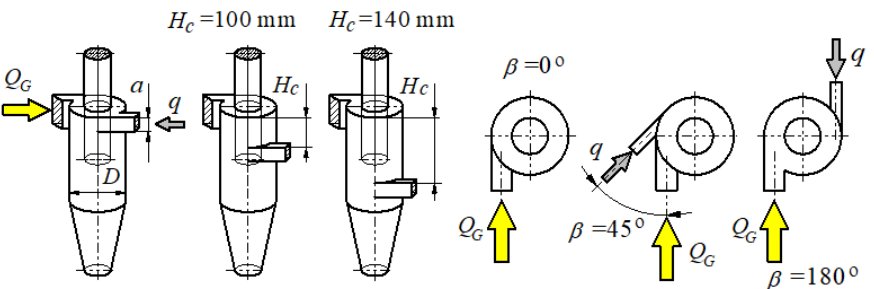
Figure 10. Reverse flow cyclone with a tangential inlet with additional inlet port in its cylindrical section. Figure made by the author based on data from paper [70].